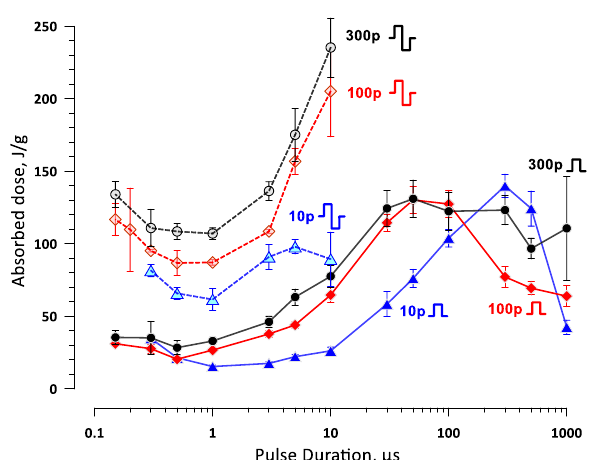
Figure 11. The absorbed dose, J/g, at the threshold for cell killing by uni- and bipolar pulses of different duration (solid and dashed lines, respectively). For bipolar pulses, the dose is plotted against the duration of one phase. The pulse shape and the number of pulses per train are labeled next to the respective curves (“10p”, “100p”, and “300p” stand for 10, 100, and 300 pulses per train respectively). Pulse repetition rate was 10 Hz. See text and Figs. 6 and 7 for more